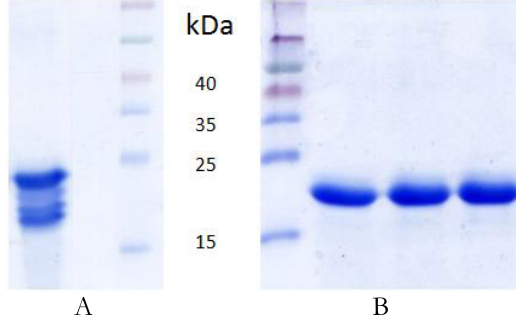
A B Figure 2. Characterization of rhIFNα-2b : A. Unpurified ; B.